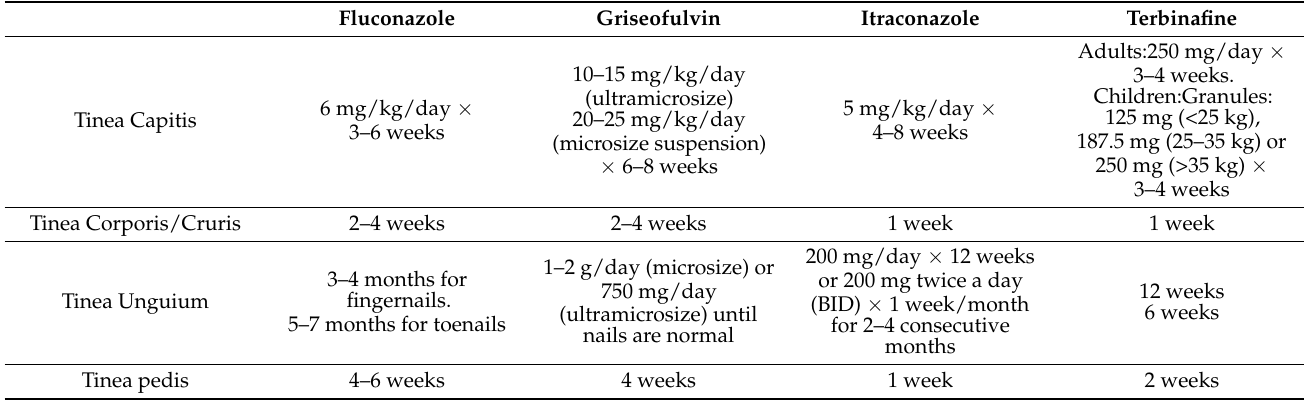
Table 2. Dose and duration of systemic antifungals in dermatophytic